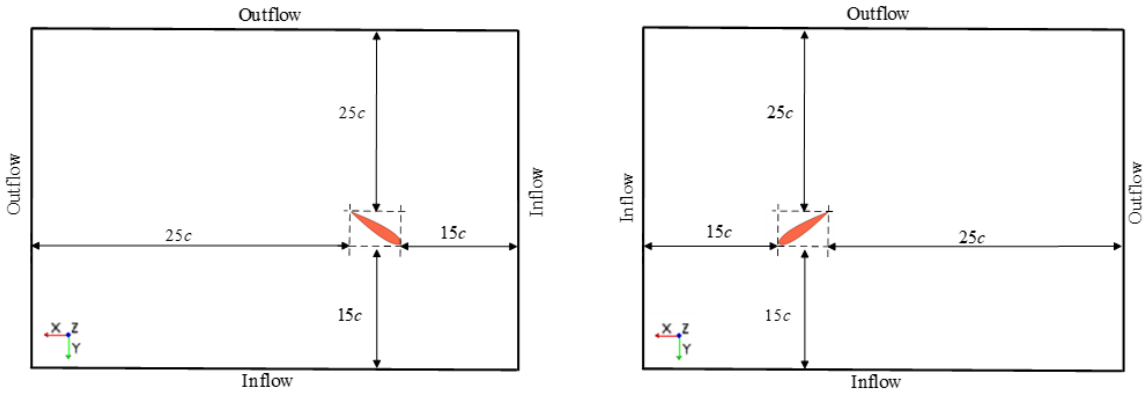
Figure 12. Setup of the computational domain of sail downwind ( left ) and upwind ( right ).